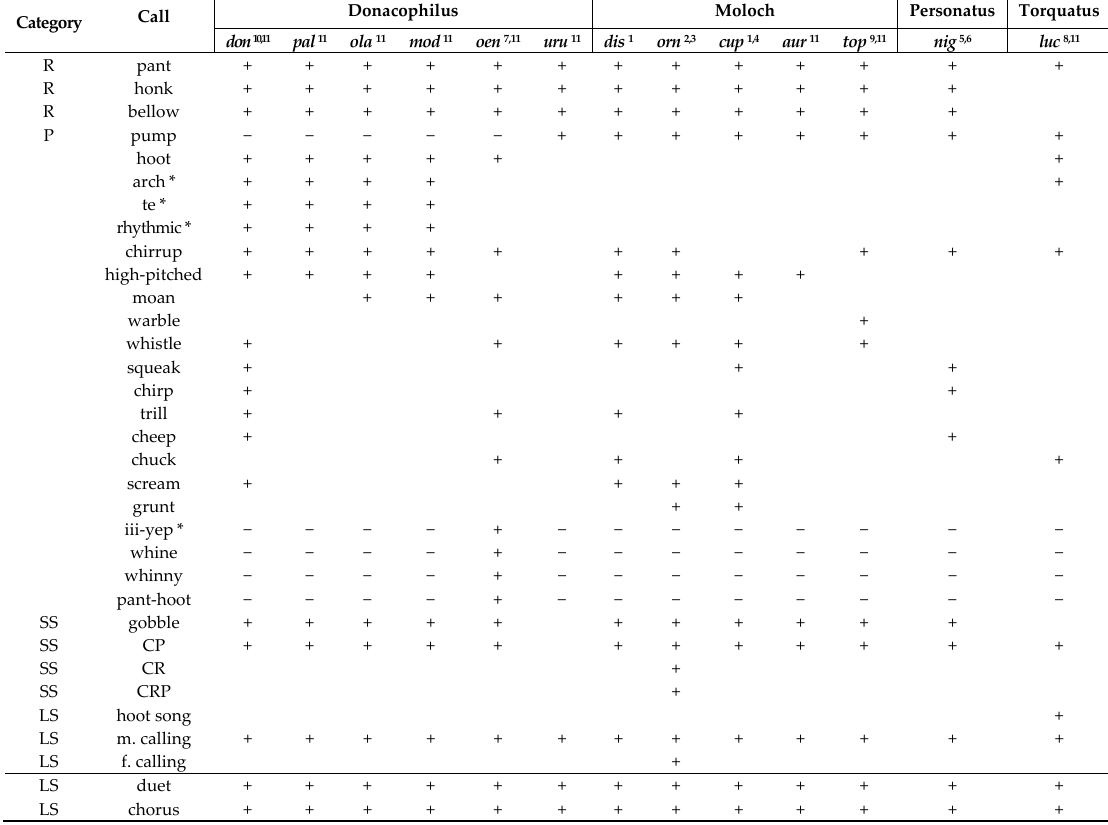
Table 2. A list of titi monkey calls described in the literature. The first three letters of each clade and each species are used as an acronym. The original studies on which the table was elaborated have been referenced with a superscript: 1 -[37], 2 -[38], 3 -[52], 4 -[44], 5 -[48], 6 -[97], 7 -[80], 8 -[83], 9 -[50], 10 -[86], and 11 -[this study]. Capital letters in the first two columns are call categories and call combinations distinguished by Moynihan [37] and Robinson [38]. R: resonating notes; P: pumping; SS: short sequence; LS: long sequence; CP: chirrup-pumping; CR: chirrup-panting; CRP: chirrup-panting-pumping. Gobble and CP are the same calls. For each species, presence or absence of a call is reported as + or − respectively. Cells for which the corresponding call might be present but has not been reported are left